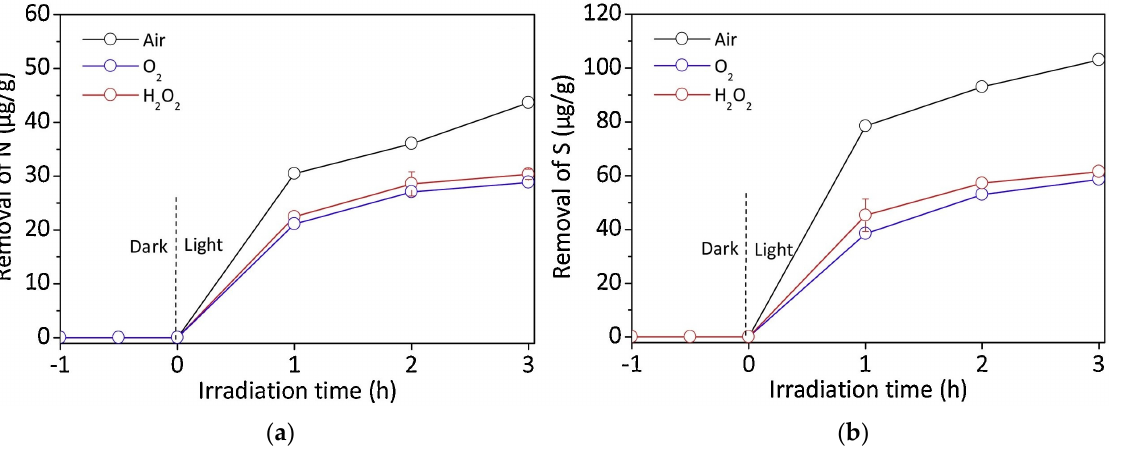
Figure 11. ( a ) Removal of pyridine using different oxidant sources. ( b ) Removal of thiophene using different oxidant sources. Adapted from ref. [36] with permission from Elsevier. Copyright 2020 Elsevier.